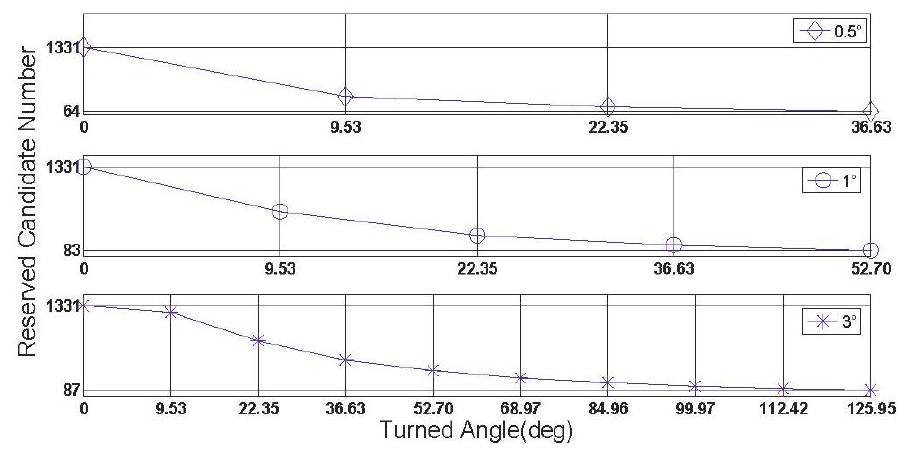
Figure 15. Size of ℤ contracts to less than 100 for each